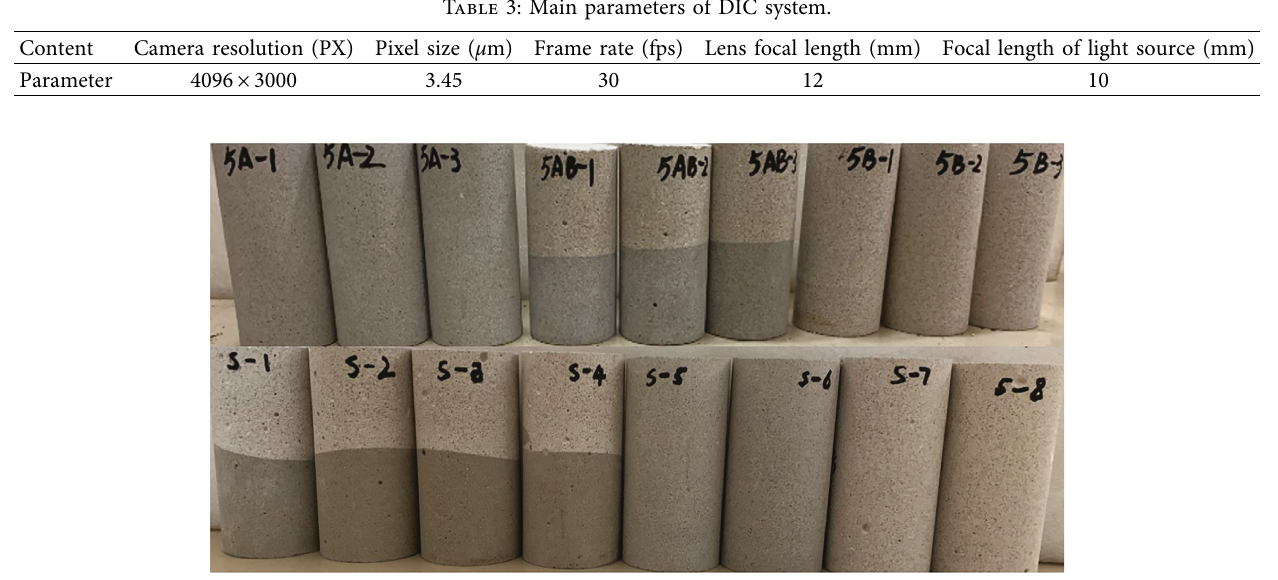
Figure 5: Layered composite rock sample. Table 4: Parameters and numbers of